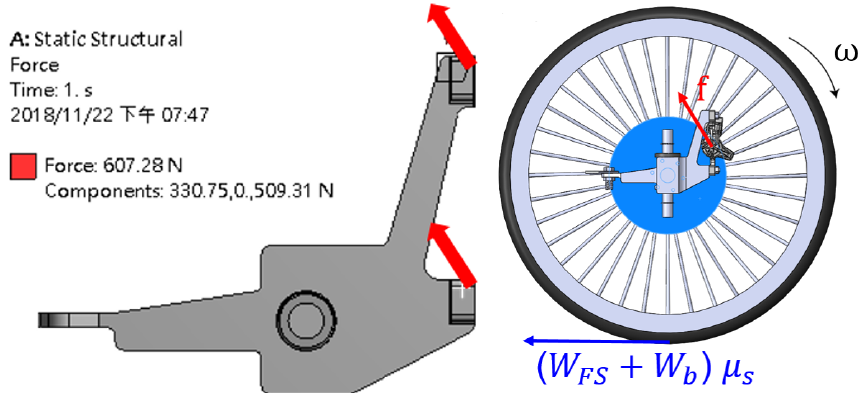
Figure 14. Knuckle (application end) and front wheel free body diagram.